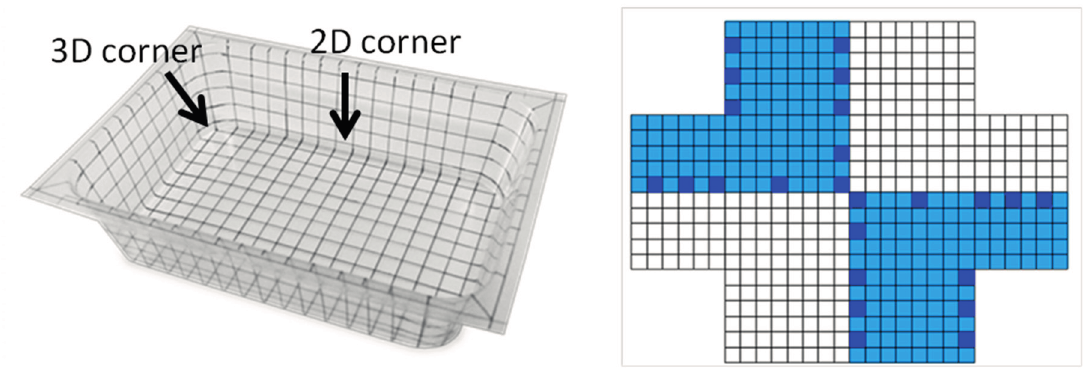
Figure 1. Validation of the global thickness measurements in 236 locations of a 50-mm